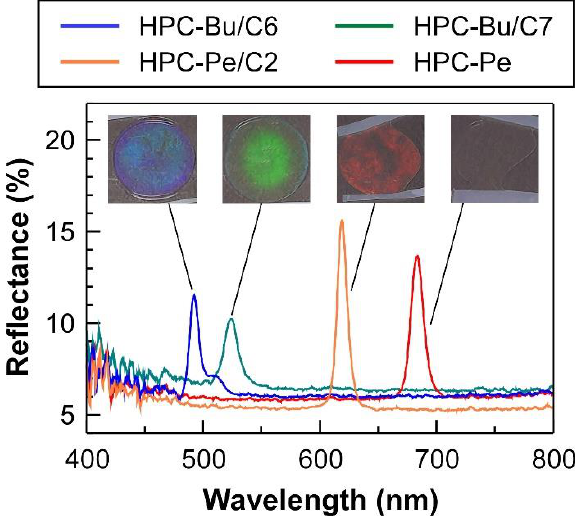
Figure 5. Reflection spectra of HPC-Bu/C6, HPC-Bu/C7, HPC-Pe/C2, and HPC-Pe at a room tem- perature of ~25 °C. The insets denote the reflection images of HPC derivatives at room temperature.